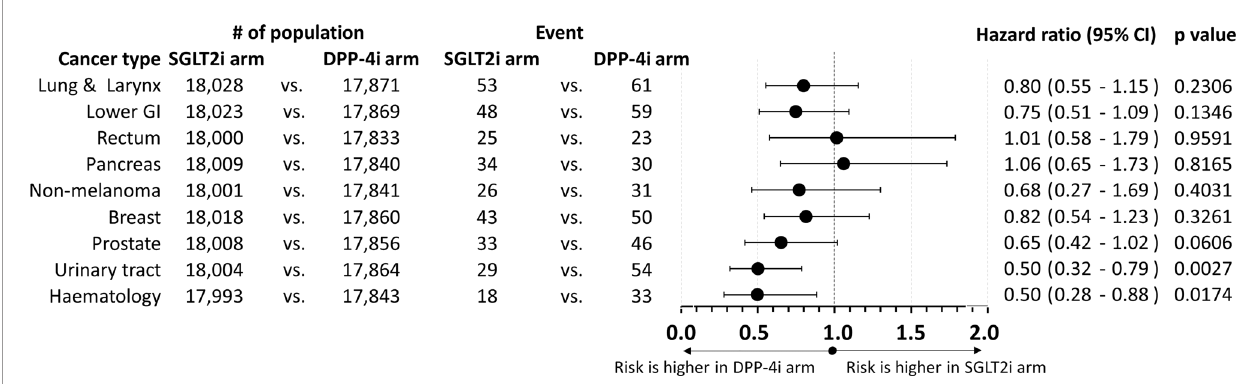
FIGURE 1 | Forest plot on the comparison of SGLT2i and DPP-4i arms and the risk of individual cancer types. Hazard ratios as well as their 95% con fi dence intervals are shown; p-values are also reported. Hazard ratios below 1.0 indicate that the risk is higher in the DPP-4i arm, whereas hazard ratios above 1.0 signify that the risk is higher in the SGLT2i arm. GI, gastrointestinal tract; SGLT2i, sodium-glucose co-transporter 2 inhibitor; DPP-4i, dipeptidyl peptidase-4 inhibitor.